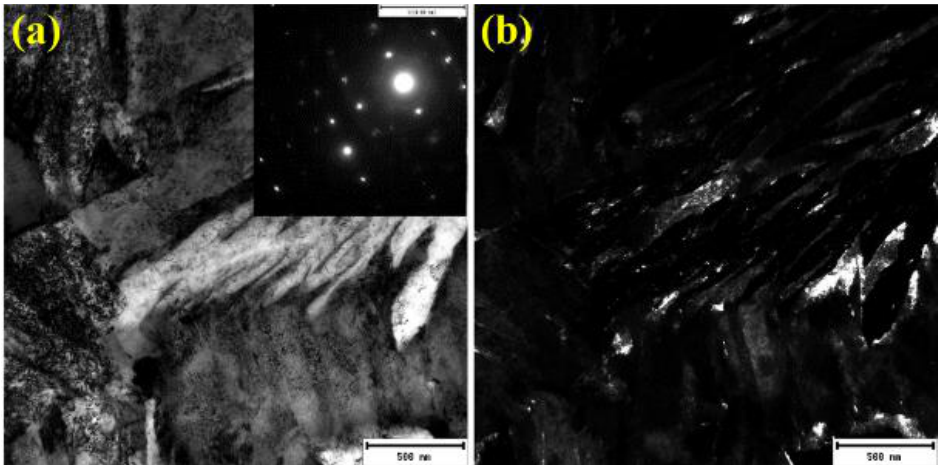
Figure 8. Transmission electron microscopy (TEM) images of Q&B heat treated sample. ( a ) Bright field (BF) image, ( b ) dark field (DF) micrograph using a {111} diffracted retained austenite phase. The selected area electron diffraction (SAED) pattern is shown as an inset in the corresponding BF image.